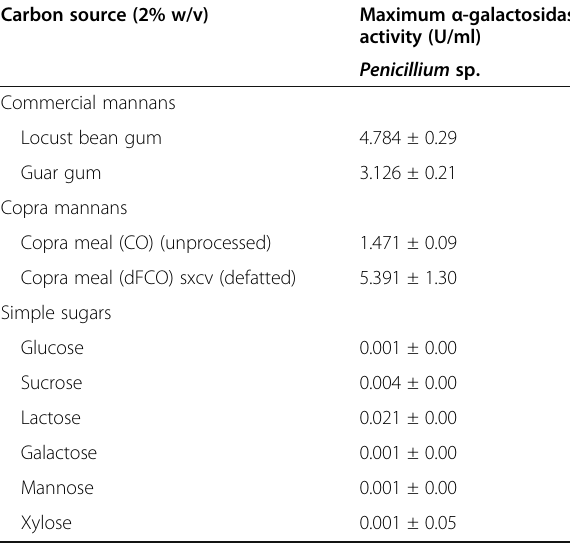
Table 1 Effect of different carbon sources on production of α -